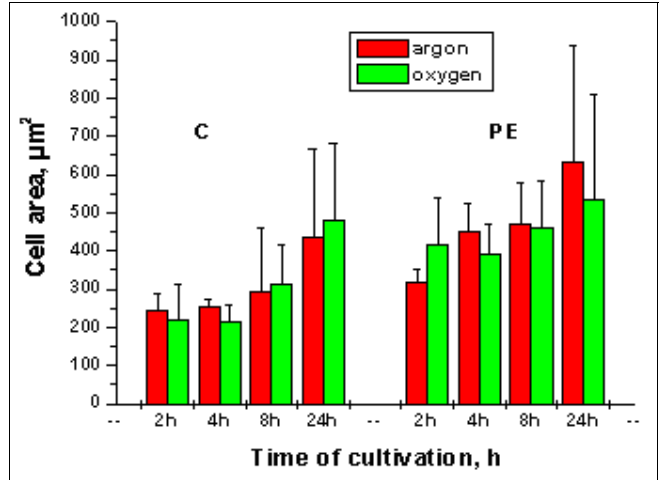
Figure 8. Comparison of cell spreading by cultivation on the C-, and PE-surfaces treated with argon and oxygen plasma. There were no statistically significant differences between the two plasma treatments (p < 0.05). The cells are less well spread on the C-surface than on the